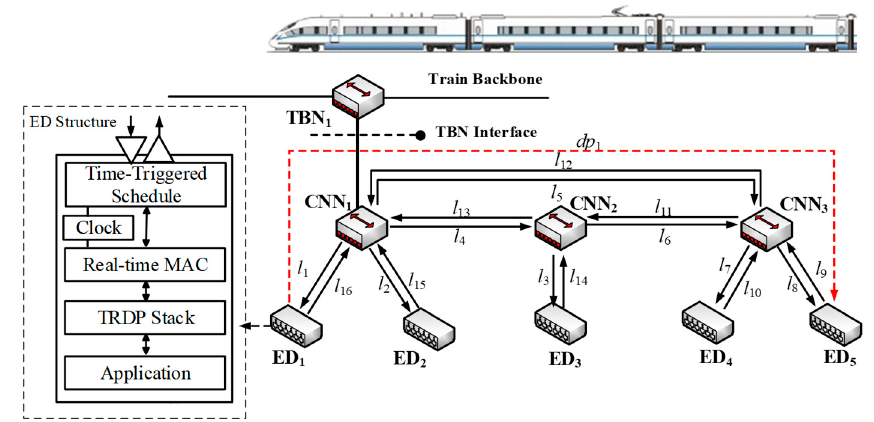
Figure 1. Topology of the proposed information system in a cyber–physical system (CPS) .